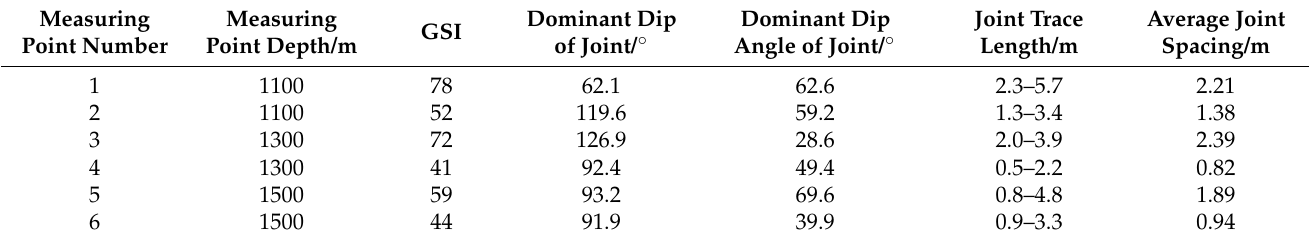
Table 2. Test information and joint occurrence statistics of each measurement point.